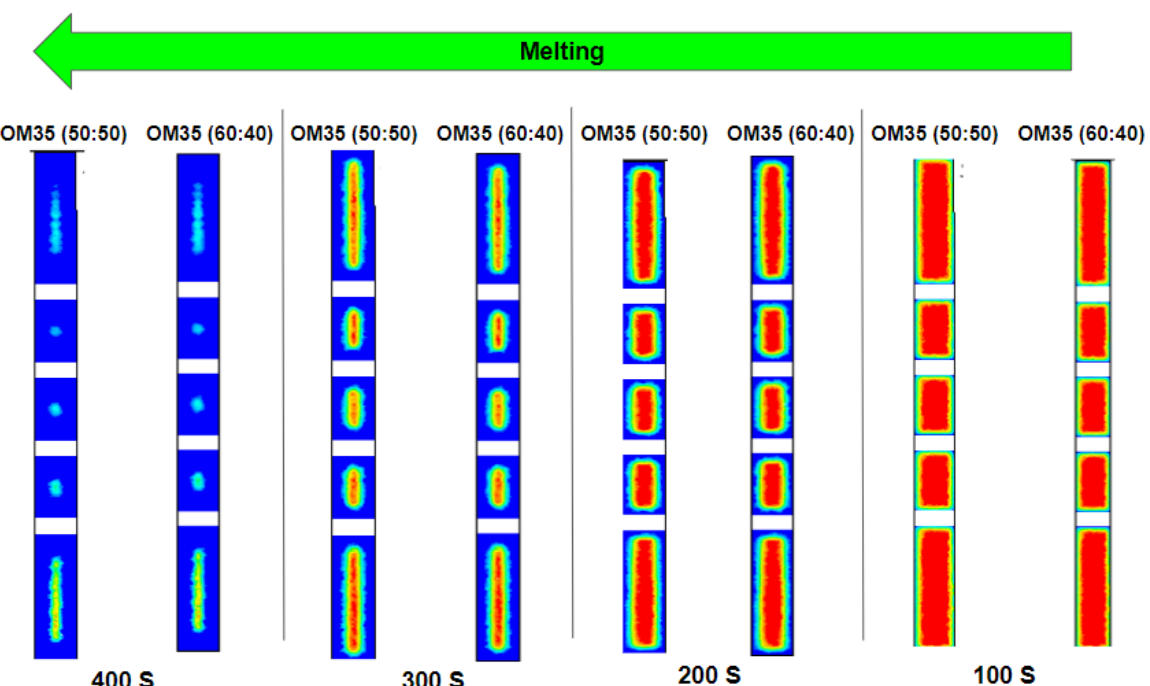
Figure 17. The heat load change with function of time.